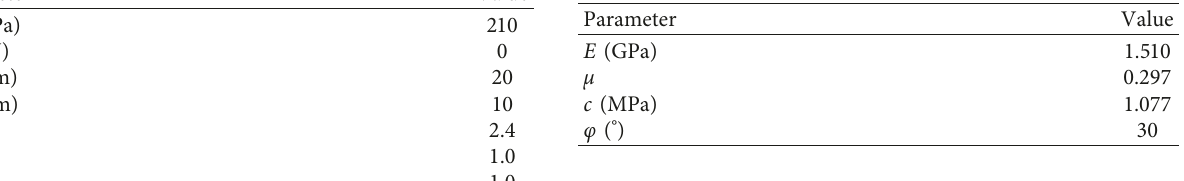
Table 2: Anchor support parameters. Table 3: Physical-mechanical parameters of the surrounding rock reinforcement